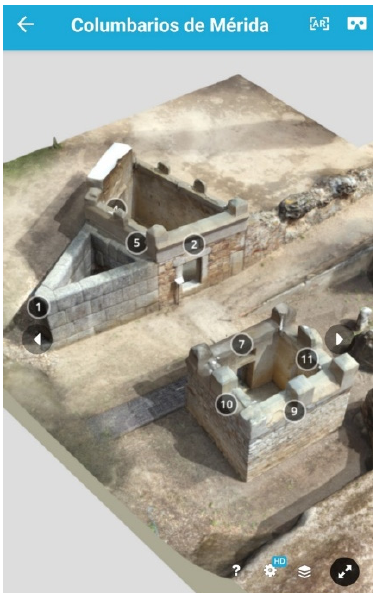
Figure 26. Different information that can be consulted in the model: ( a ) Material characterization; ( b ) archaeological information; ( c ) pathological information.